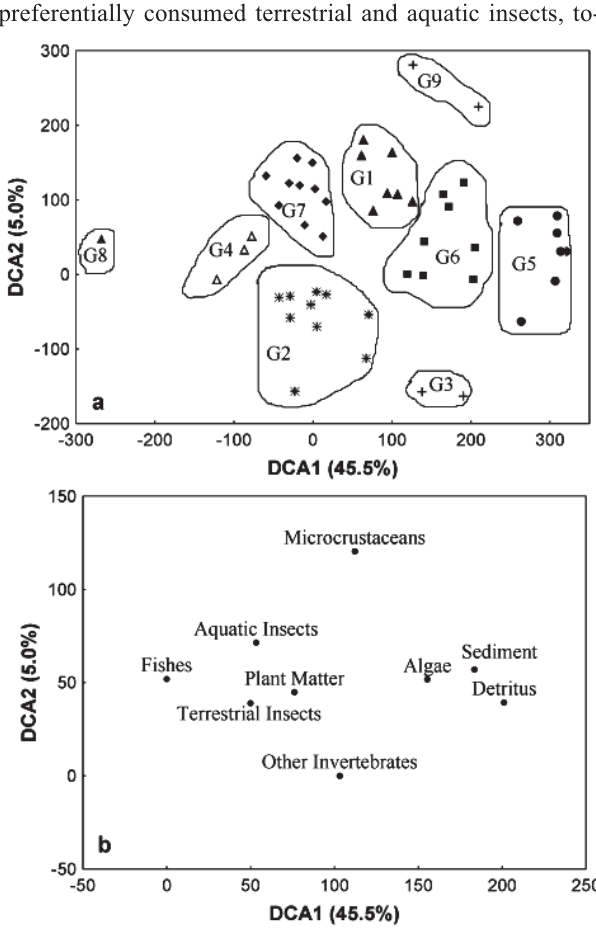
Fig. 1. Scores for the fish species (a) and their food items (b) along Axes 1 and 2, derived from detrended correspondence analysis (DCA). The circles in (a) indicate the groups deter- mined by the k-means analysis.